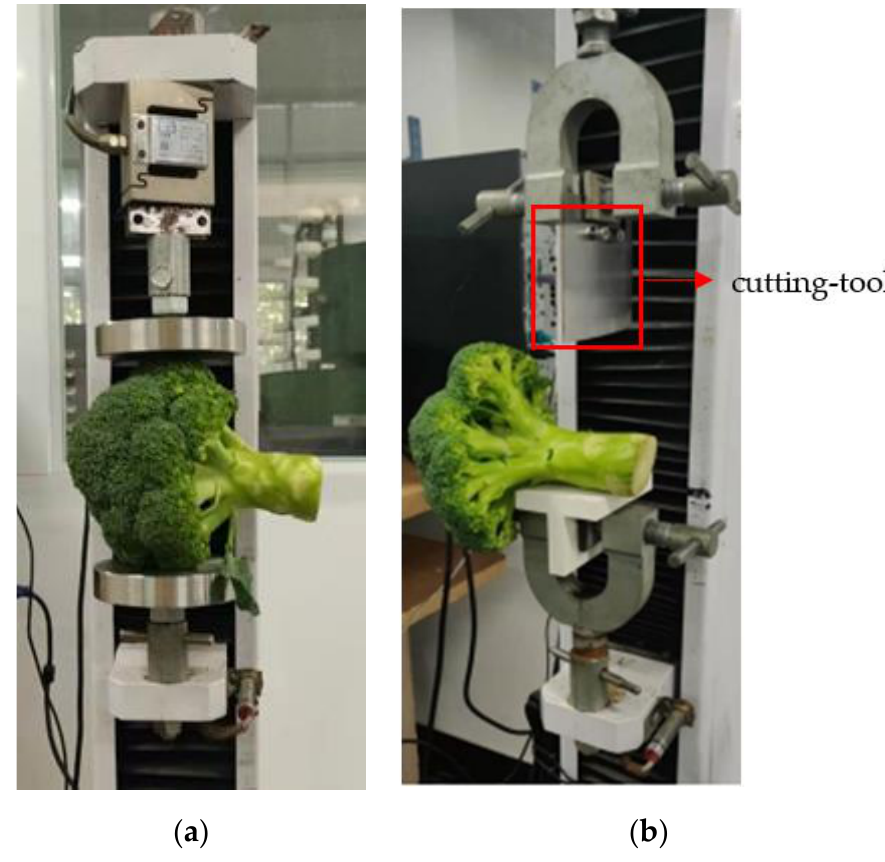
Figure 5. Broccoli physical damage test: ( a ) Flower ball pressure test; ( b ) Stem-cutting force test.